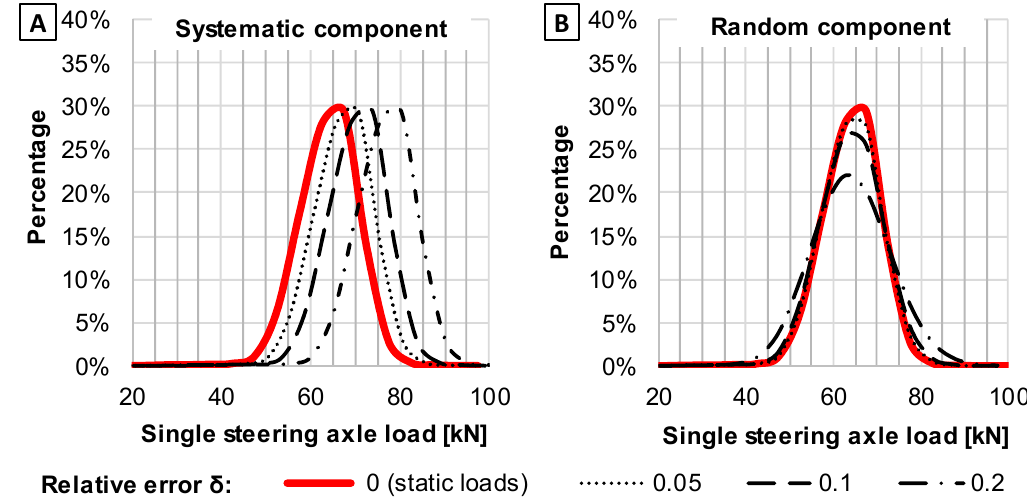
Figure 1. An example of the e ff ect of ( A ) systematic and ( B ) random components of relative error on axle load spectrum (ALS).